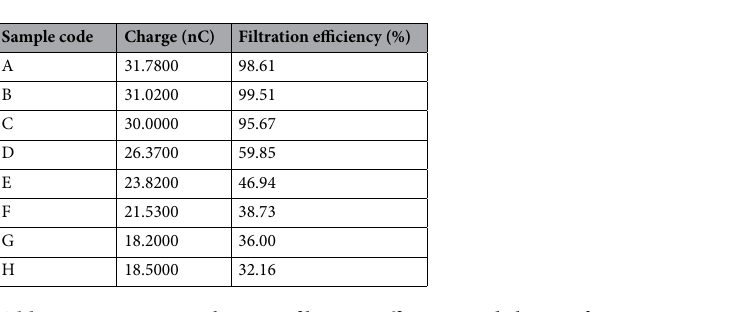
Table 6. A comparison between filtration efficiency and charge of PP MB_NW samples A–H.